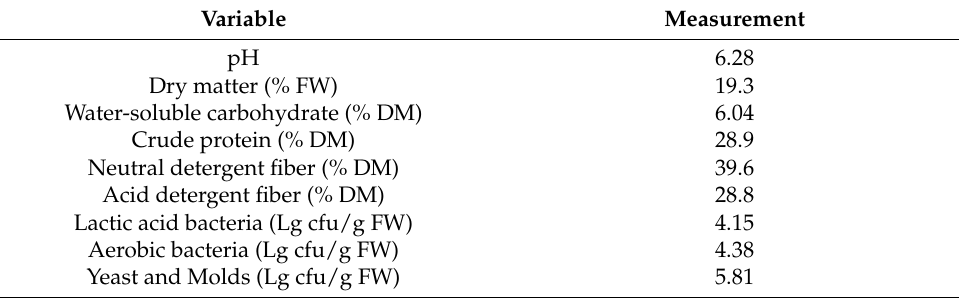
Table 1. Nutrient and microbial composition of fresh